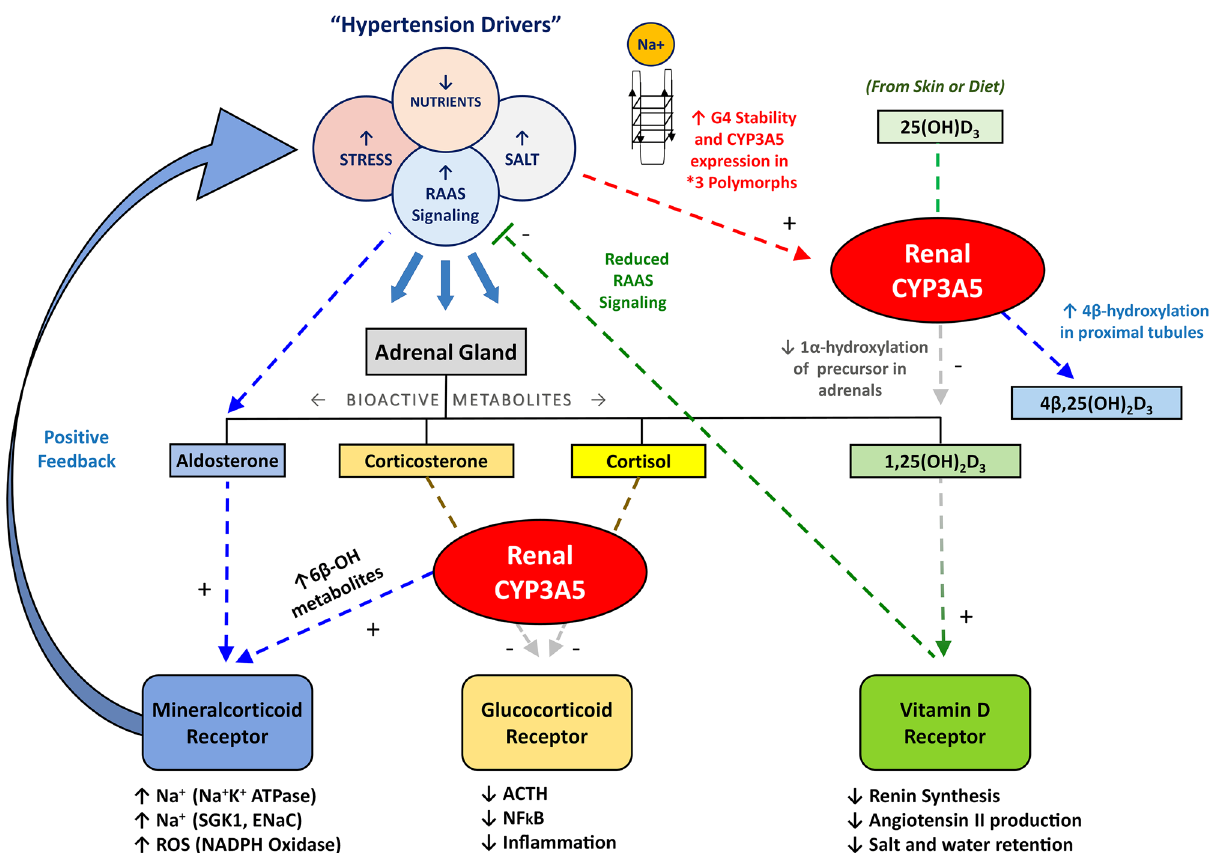
Figure 6. Schematic Diagram of CYP3A5 ′ s Dual Role in the Regulation of Hypertension. Environmental factors (e.g., diet, chemical exposure, and stress) and homeostatic signaling mechanisms (i.e., Renin– Angiotensin–Aldosterone System (RAAS)) can alter renal and adrenal gland function to promote hypertension in humans. There is increasing evidence that renal CYP3A5 activity plays a dual role in modulating vitamin D- and glucocorticoid-hormone signaling cascades that drive HBP pathology. First, CYP3A5 activity can convert stress-related glucocorticoids (corticosterone and cortisol) to mineralocorticoids via 6β-hydroxylation, which enhances MR signaling and triggers sodium retention (via several transporter related mechanisms) and increased ROS production. This activity also silences glucocorticoid signaling (via ACTH and NFkB) and increases inflammation. Second, CYP3A5 can hijack endogenous vitamin D hormone signaling cascades by shunting 25-hydroxyvitamin D 3 metabolism from CYP27B1 (1α-hydroxylase) towards a 4β-hydroxylation pathway that limits 1,25-dihydroxyvitamin D 3 signaling via the VDR, reducing renin production that suppresses systemic RAAS activity. Thus, CYP3A5 appears to play a pathological endogenous role in many human polymorphs by regulating positive feedback loops that drives the accumulation of stress hormones and sodium in the renal proximal tubule cells. Sodium cationic-stabilization of G4-like elements in CYP3A5 intron 3 may exacerbate this hypertensive signaling arc in CYP3A5 *1/*3 and *3/*3 polymorphs, who may conditionally express the gene. This salt-sensitive positive feedback loop may mask any adaptive effects of the 6986A/G polymorphism (rs776746) by promoting stress- and dietary-sensitive expression of CYP3A5, complicating any GWAS studies focused on the *1/*3 or *3/*3